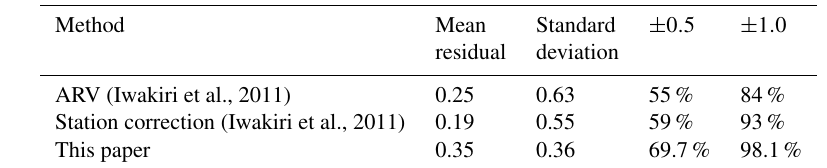
Figure 9. An example of simulation from IBRH19 (surface) to IBRH10 (surface) for the earthquake 201202191454: (a) the observed surface acceleration for IBRH19, (b) the observed surface acceleration waveform (blue) compared with the simulated one (red), (c) the spectral ratio of observed surface record for IBRH19, and (d) the observed spectra of surface record at IBRH10 (blue) compared with the simulated one (red). Table 6. The comparison